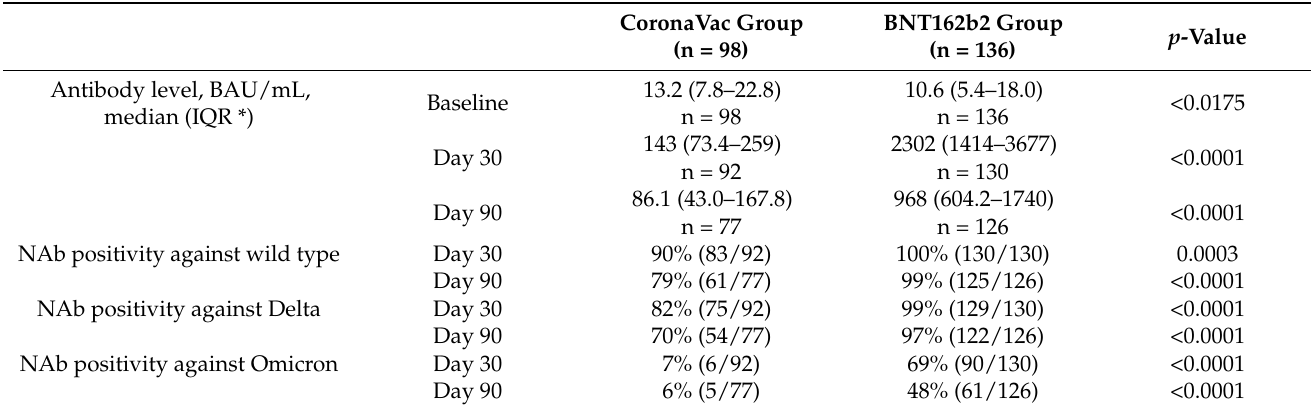
Table 2. Quantitative IgG level against Spike protein and neutralizing antibody (NAb) positivity after CoronaVac and BNT162b2